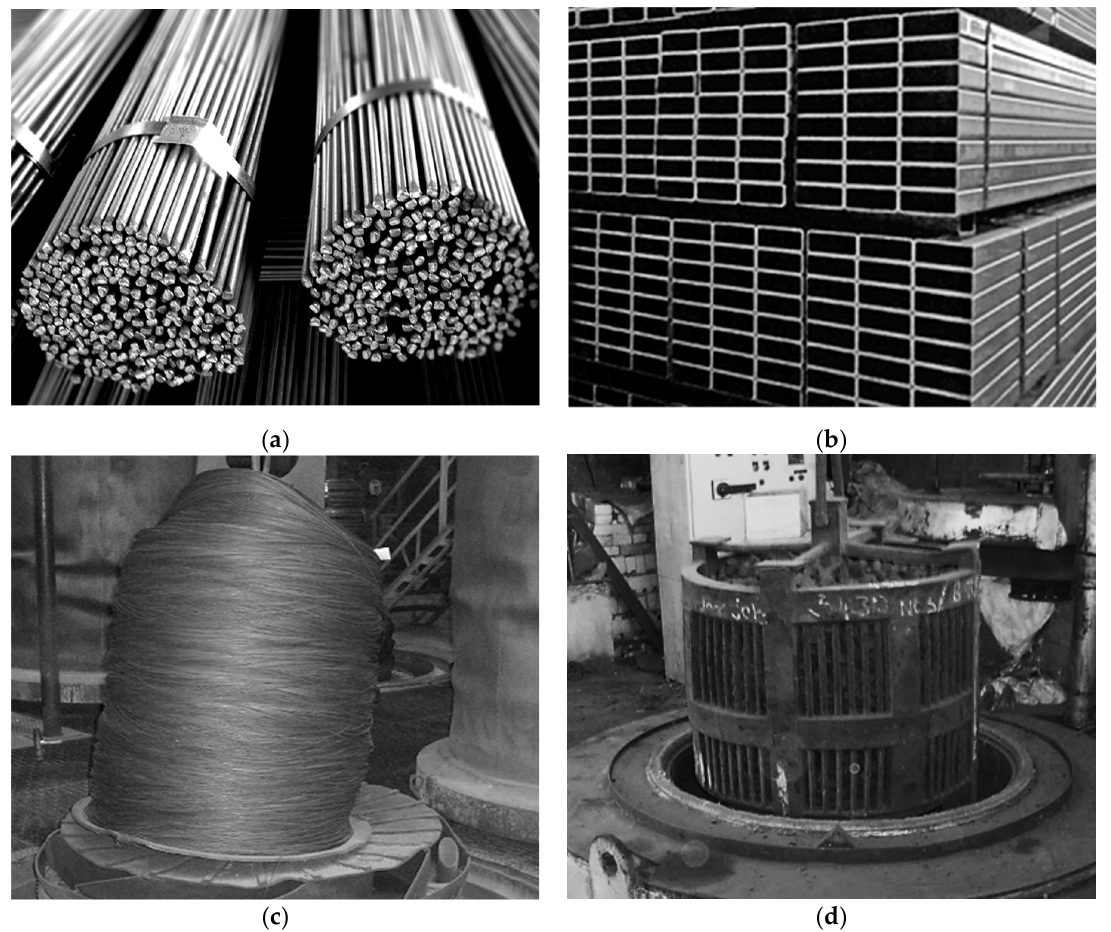
Figure 1. A steel porous charge in the form of a: ( a ) round bar bundle; ( b ) rectangular section bundle; ( c ) wire coil; ( d ) piece charge.